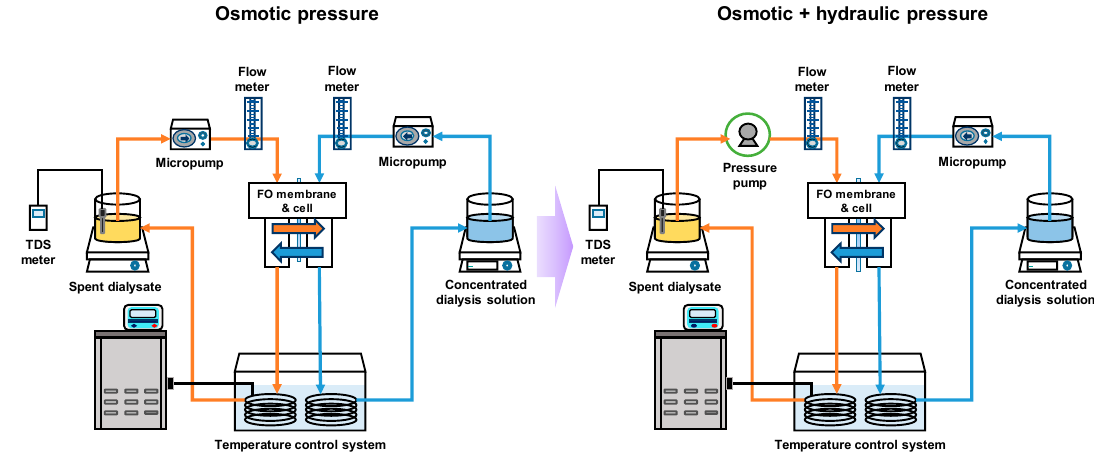
Figure 1. Schematic diagram of the FO & PAFO experiment system.